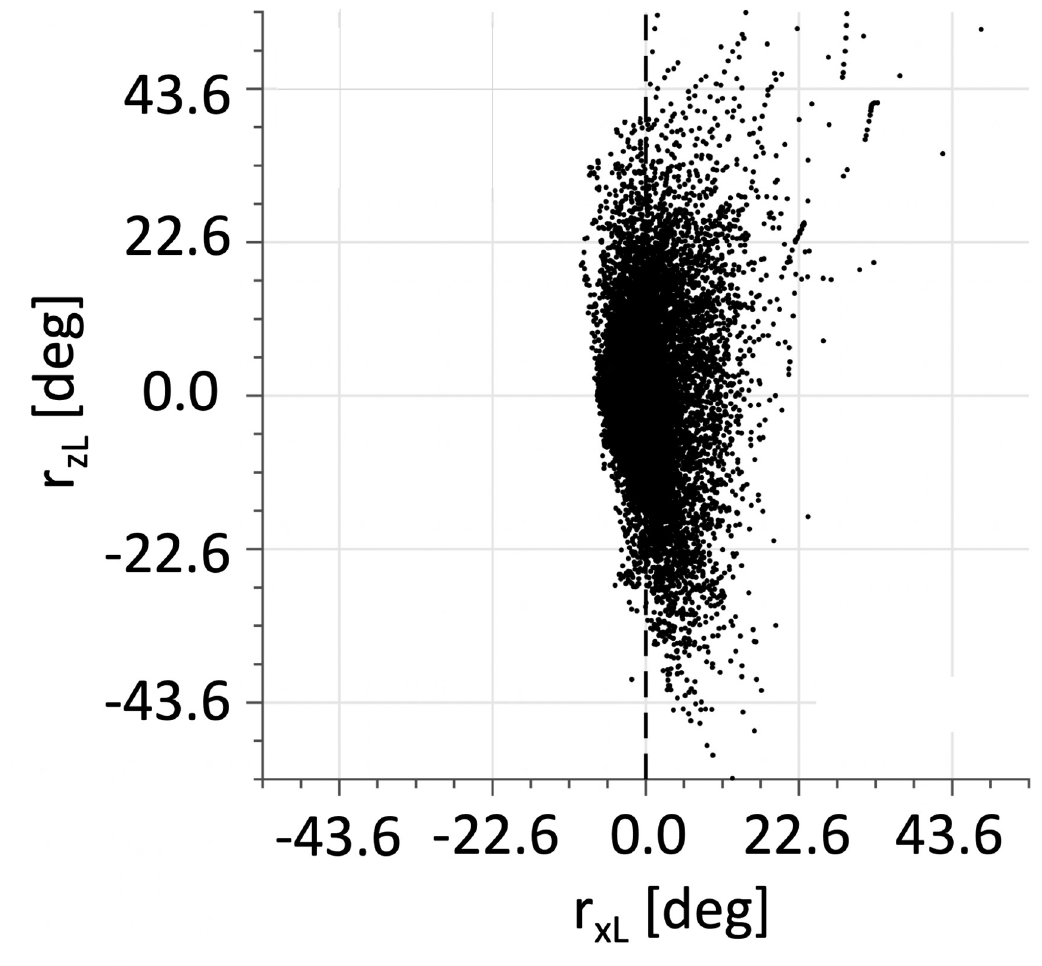
Fig 10. Same data as in Fig 9, but rotated by R (Eq 32), so that it is expressed in the reference frame in which the primary p position (the normal to the best-fit plane) coincides with P = [1, 0, 0]. This is defined as Listing’s reference frame. Compare to Fig